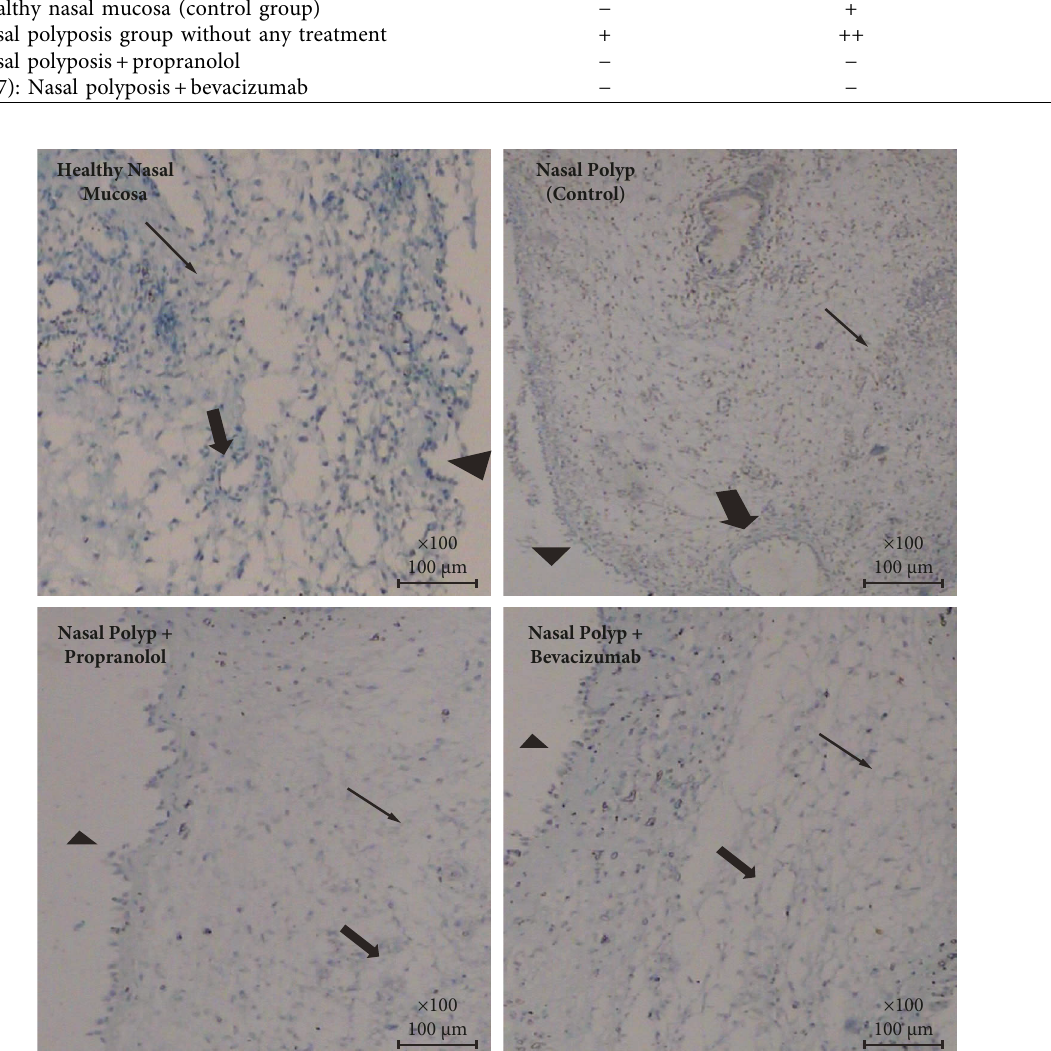
Figure 1: VEGF-A expressions on each group: A slight expression is observed in normal mucosa and nasal polyp group; this expression was absent in propranolol and bevacizumab group (arrow head: mucosa, thick arrow: capillaries, thin arrow: intersisium (VEGF-A, IHC,